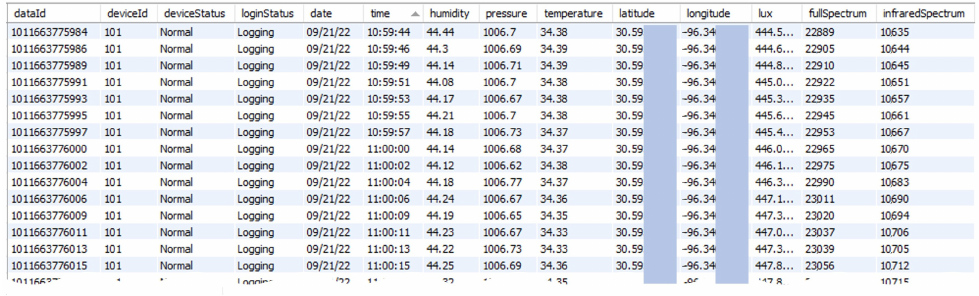
Figure 6. Various data from the device ID 101